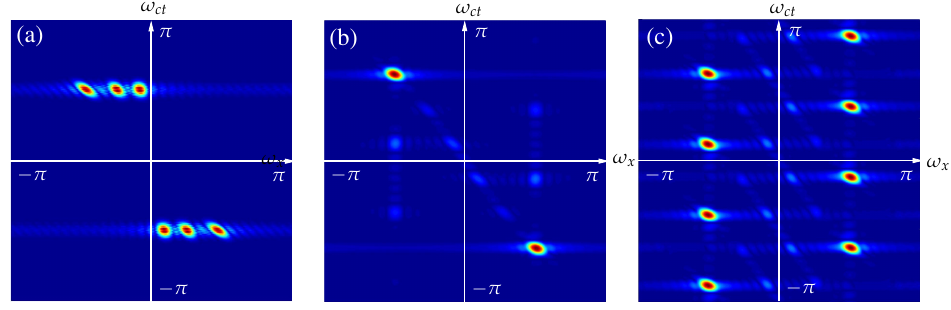
Figure 6. Frequency response of four-phase 2D IIR beam filter tuned to enhance RF signals arriving at a DOA of ψ = 35 ◦ . ( a ) response after interpolating the beamformed output of four phases; decomposed polyphase response of ( b ) two phases illustrating the temporal domain aliasing effect and ( c ) frequency response of a single phase.